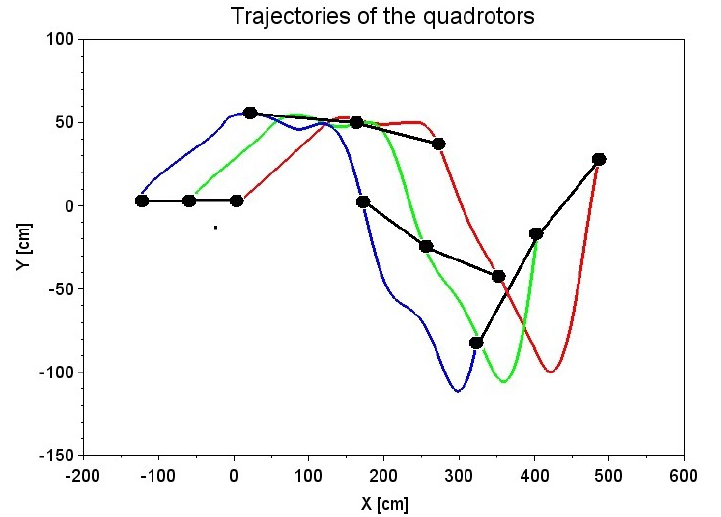
Figure 9. Position of the drones and the DLO at different moments of Experiment 1. Color code: red, green and blue correspond to leader, mid and rear drones, respectively.